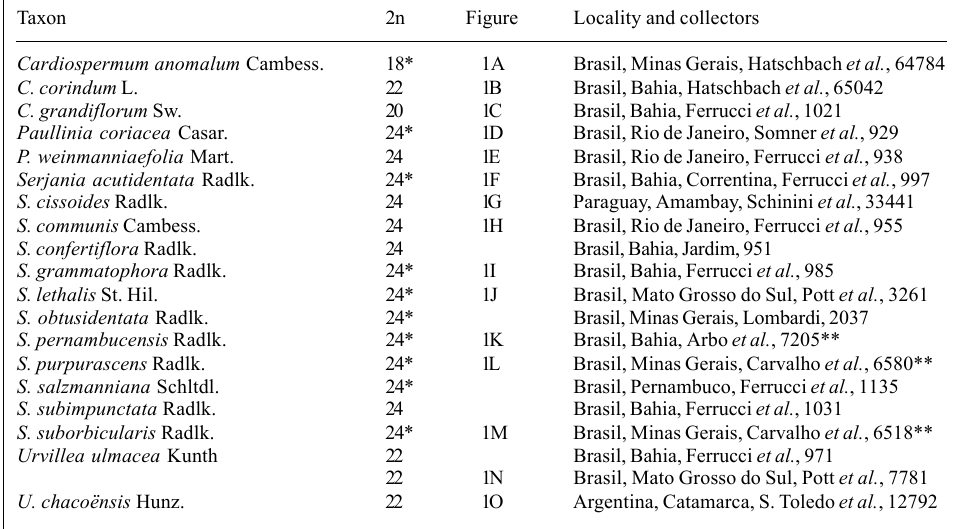
Table I - Chromosome numbers of some South American Sapindaceae , Paullinieae . *New species counts, ** participation of the author in material collection. Taxon 2n Figure Locality and collectors Cardiospermum anomalum